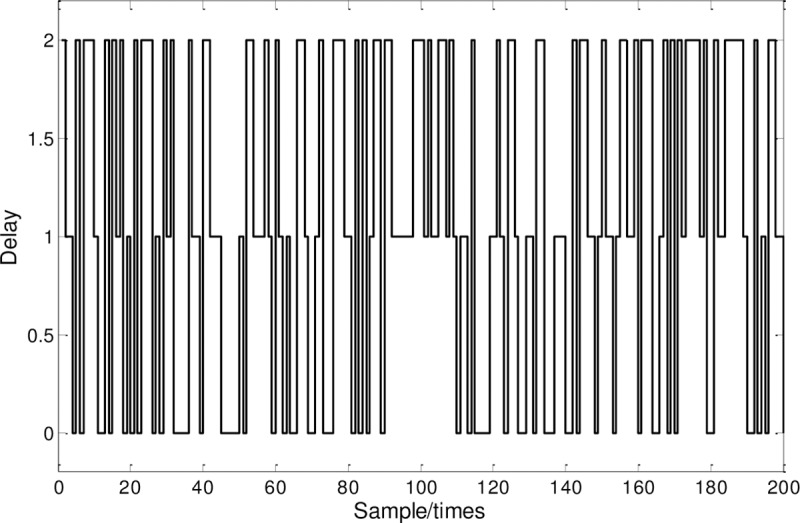
Delay distribution.